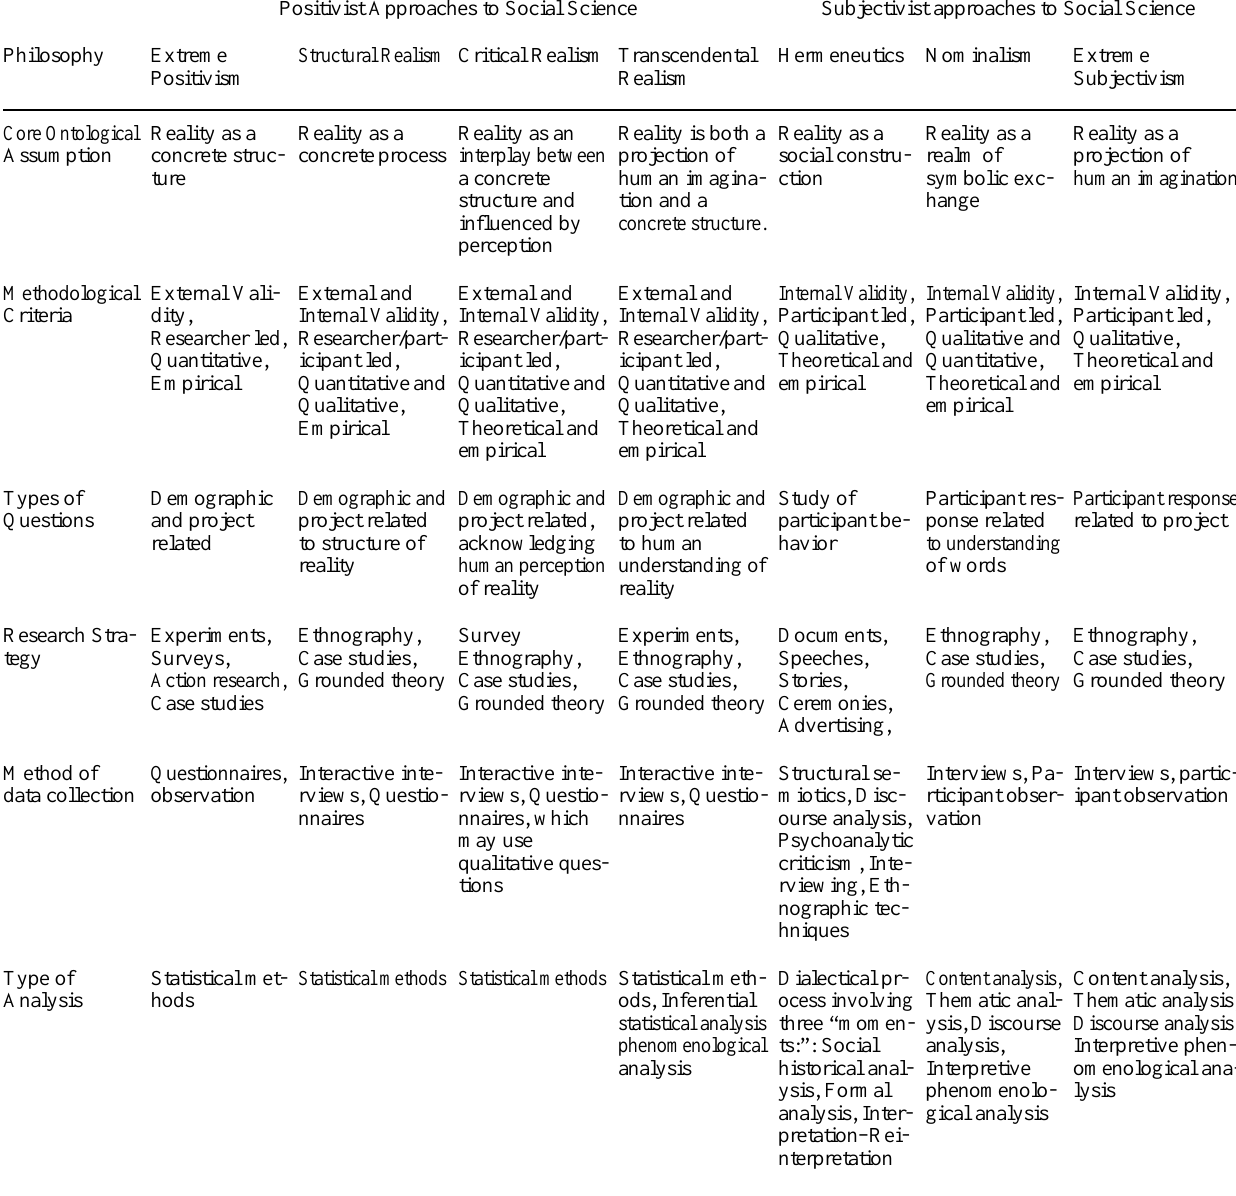
Table 2. Some of the many different philosophies that underpin social research, presented along a positivist– subjectivist continuum. The table demonstrates how the philosophies influence research strategies and methodologies, etc. (based on Crockett 1950, Brandt 1957, Feyerabend 1962, 1981a, 1981b, Husserl 1962, 1965, Marcuse 1965, Ricoeur 1978a, 1978b, 1978c, Sneed 1982, Burgess 1983, Brown 1987, 1998, 2006, and on extensive discussion with 12 researchers from different social science backgrounds at Aberdeen and Aberystwyth